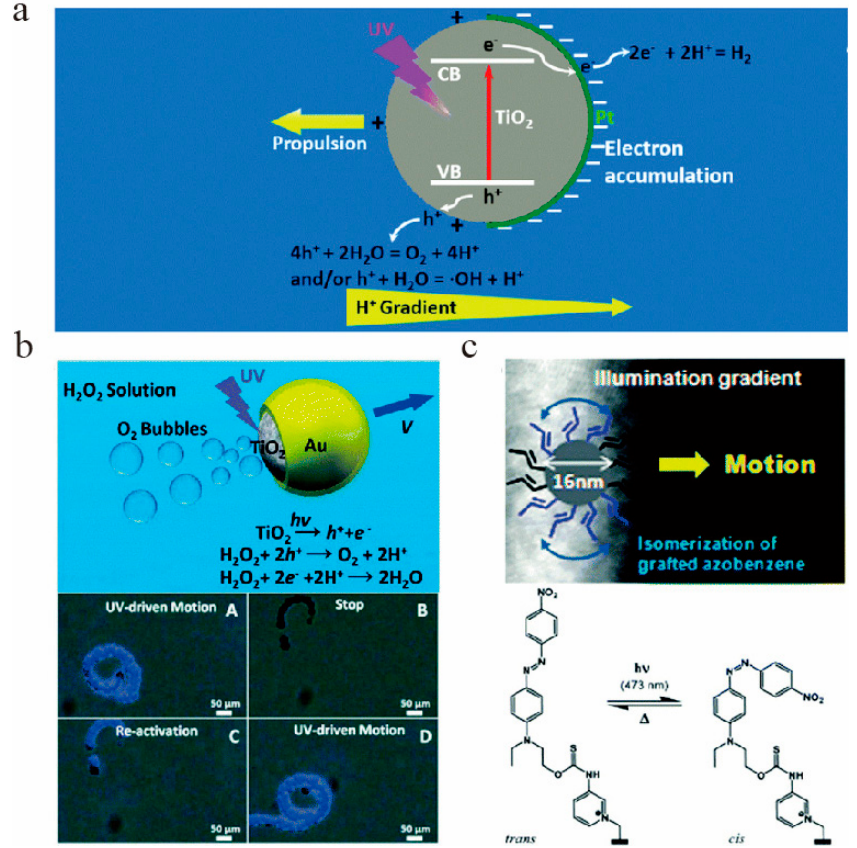
Figure 3. ( a ) Photocatalytic reaction occurs on TiO 2 /Pt to produce a chemical gradient drive